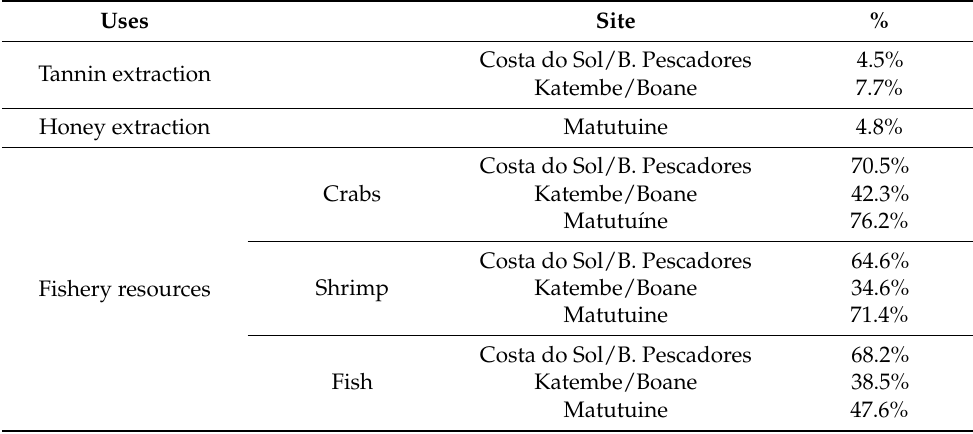
Table 7. Distribution of respondents for other exploited resources in Maputo Bay. Uses Tannin